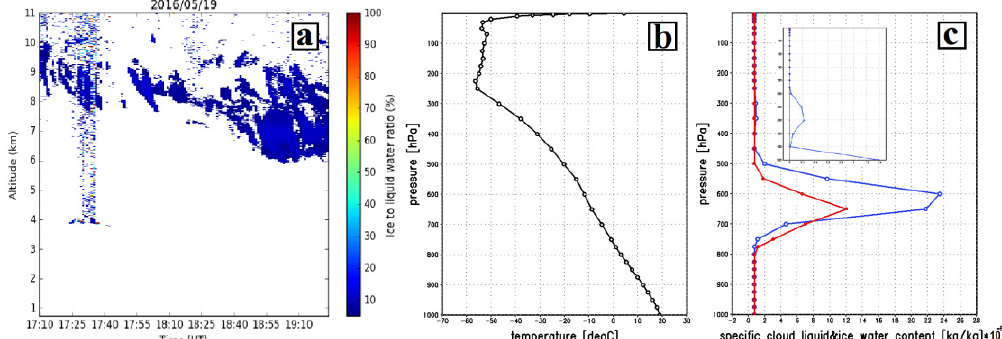
Figure 6 Time series of ice to liquid water ratio from lidar measurements (a profile of T 0 C (b) and CIWC (blue line) & CLWC (red line) (c) from ECMWF ERA - Interim reanalysisfor May 19 th , 2016